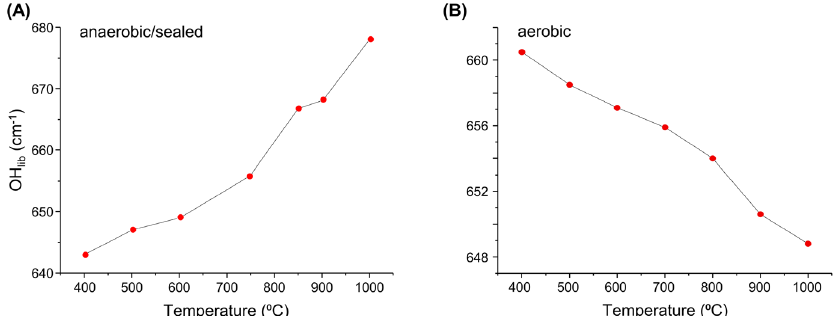
Figure 7. Temperature dependence of the INS hydroxyapatite´s hydroxyl libration for human femur: ( A ) burned under anaerobic/sealed conditions (data measured in MAPS, with 2024 cm −1 incident energy); ( B ) burned under aerobic conditions (data measured in TOSCA).